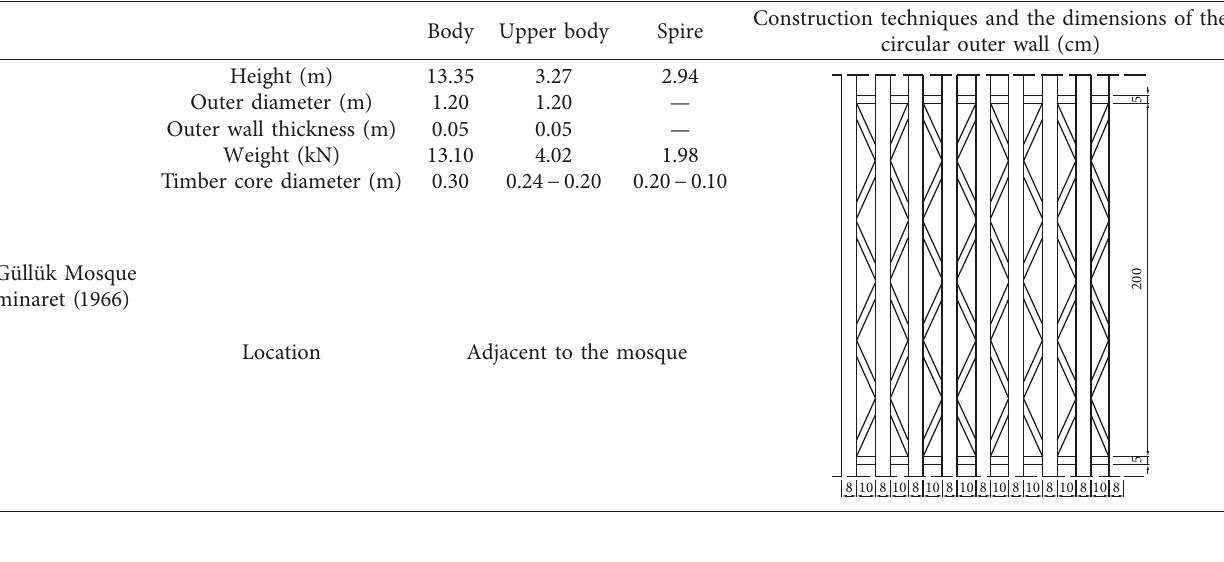
Construction techniques and the Upper Body Spire dimensions of the circular outer wall body (cm)